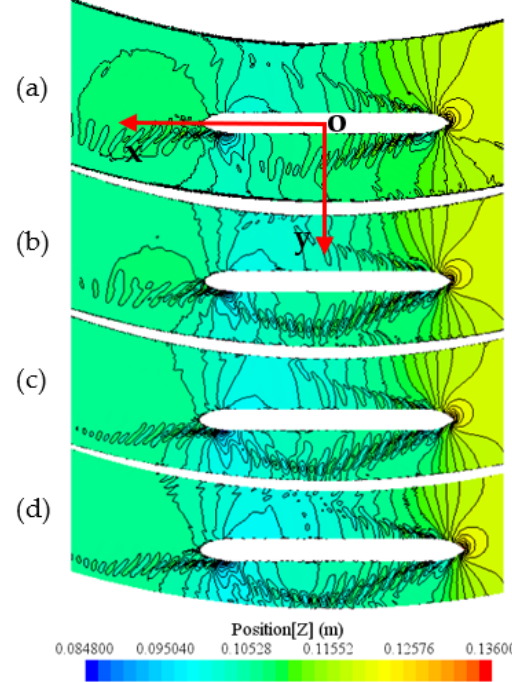
Figure 12. Free surface elevation contours of slope angle variation. ( a – d ): slope angle is 13°, 27°, 50°, 90°, respectively.